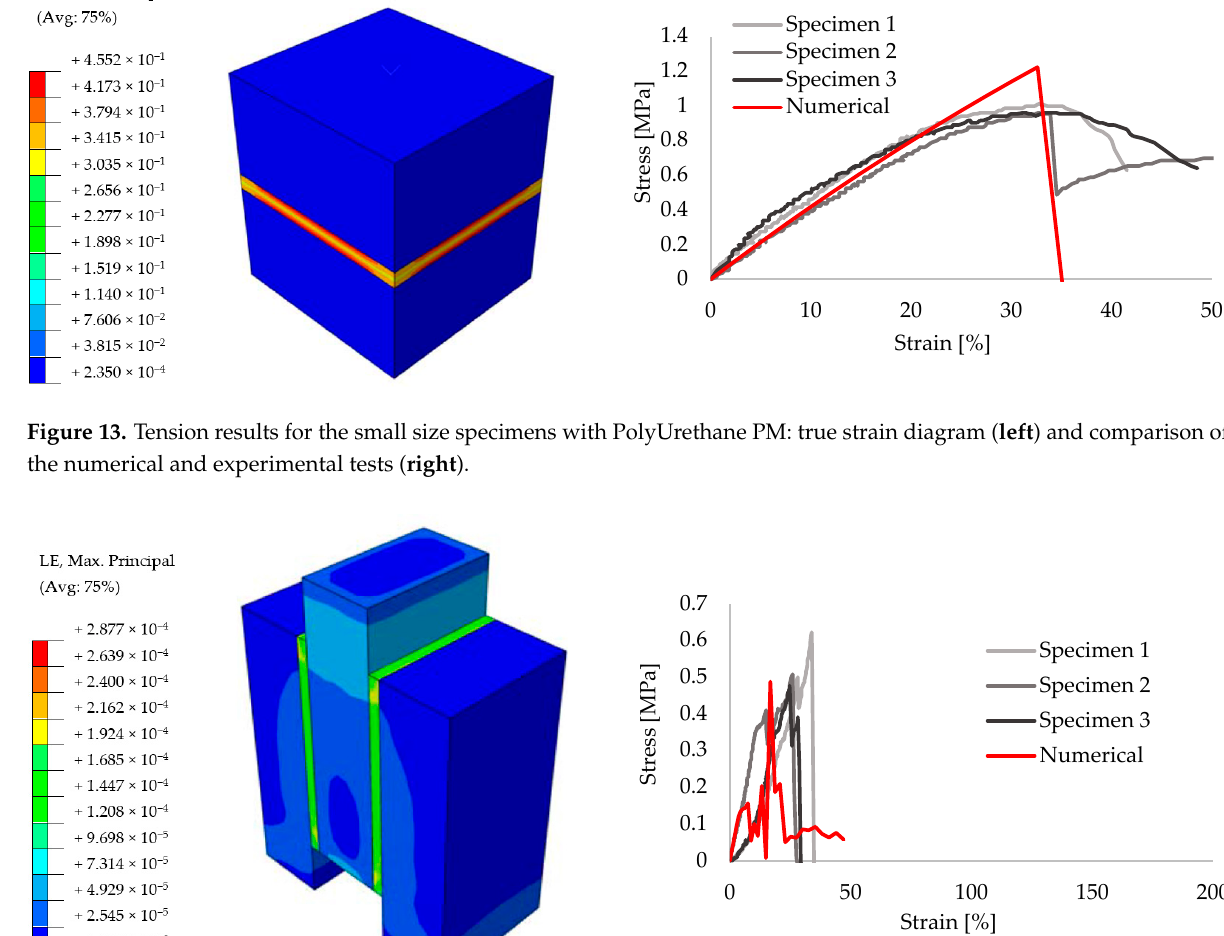
numerical and experimental tests ( right ).